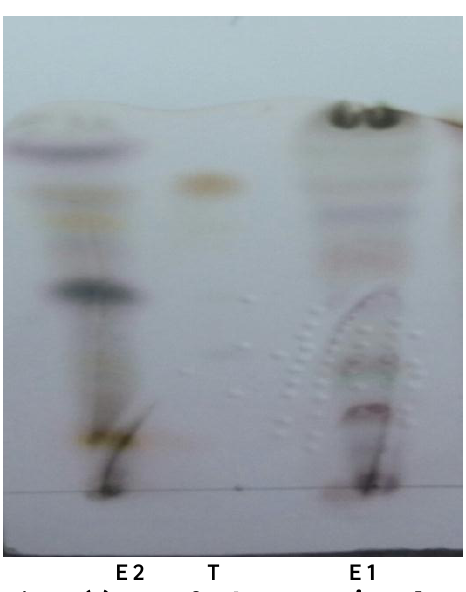
Figure (5) : TLC for Agave americana leaves extract obtained by extraction methods No.1 and No.2 using silica gel GF as adsorbent 254 and (S ) as solvent system . Visualization by 2 Liebermann-Burcrhard spray reagent.